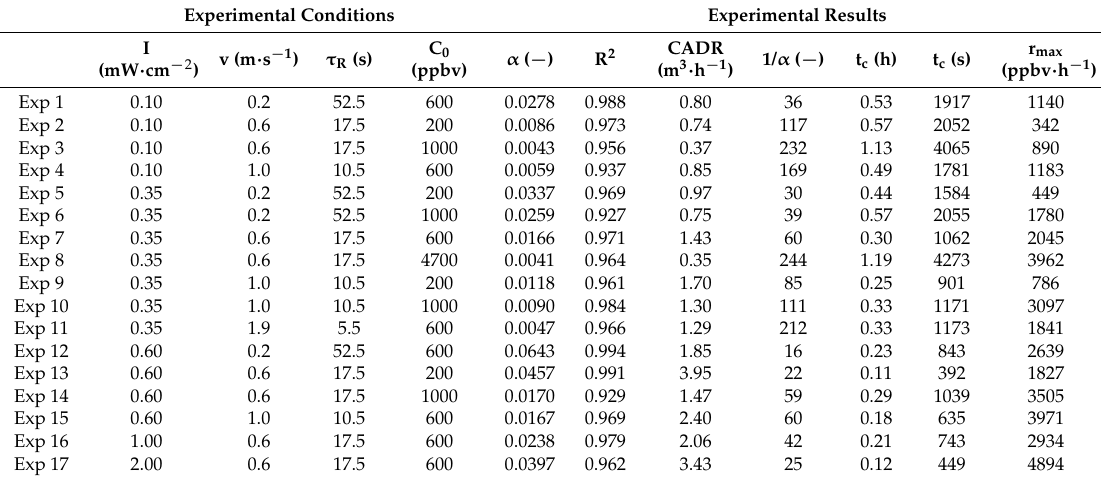
Table 1. Operating conditions used in each experiment and experimental results. Experimental Conditions Experimental